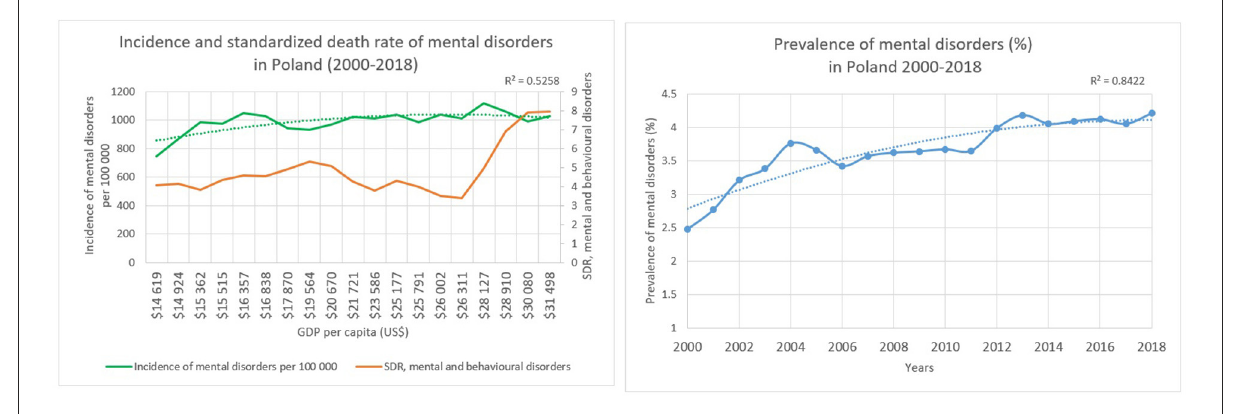
FIGURE1 Characteristics of Poland.